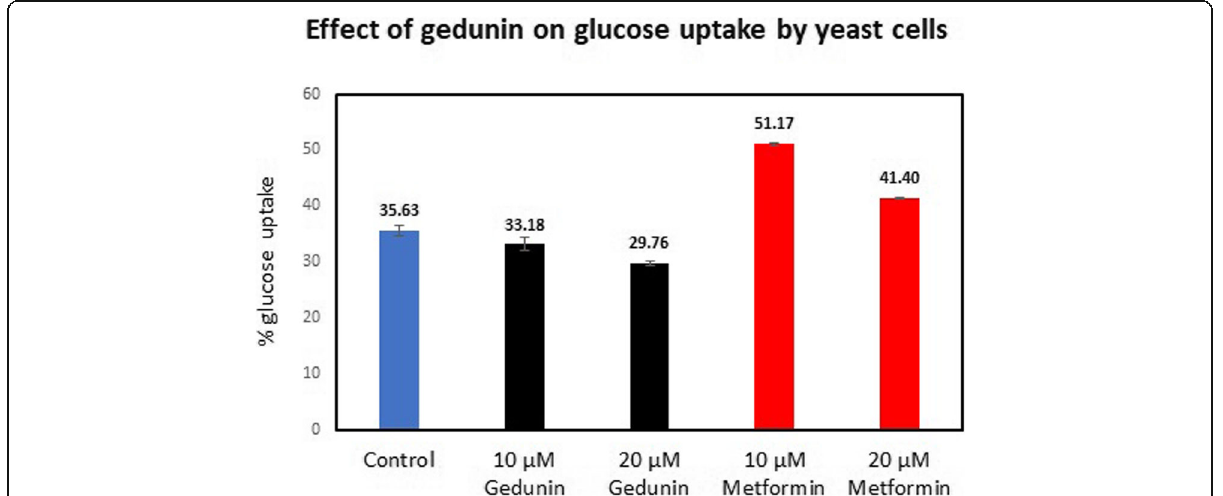
Fig. 8 Percentage glucose (10 mM) uptake by yeast cell at different concentrations of gedunin and acarbose (standard drug). Values represents mean ± SD for three independent experiments and error bars represent standard error